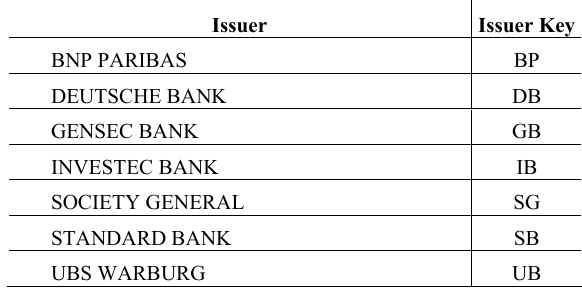
Table 1: Institutions issuing warrants on the